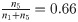
Sample size effects in logistic regression.A: Logistic model for Nursing Home Compare ‘Rehospitalized’ data and ‘1 star, 5 star’ overall rating. The moving average ‘5 star’ proportion is included for reference. The ‘5 star’ sample size proportion, n5n1+n5=0.66, is shown as a horizontal line; n1 = 1394, and n5 = 2649. B: Normalized ‘5 star’ proportion adjusted for unequal sample sizes, and the adjusted logistic curve. The midpoint value, x0 = 22.4, for the logistic curve is shown as a vertical line; the ‘Rehospitalized’ median is 22.2.